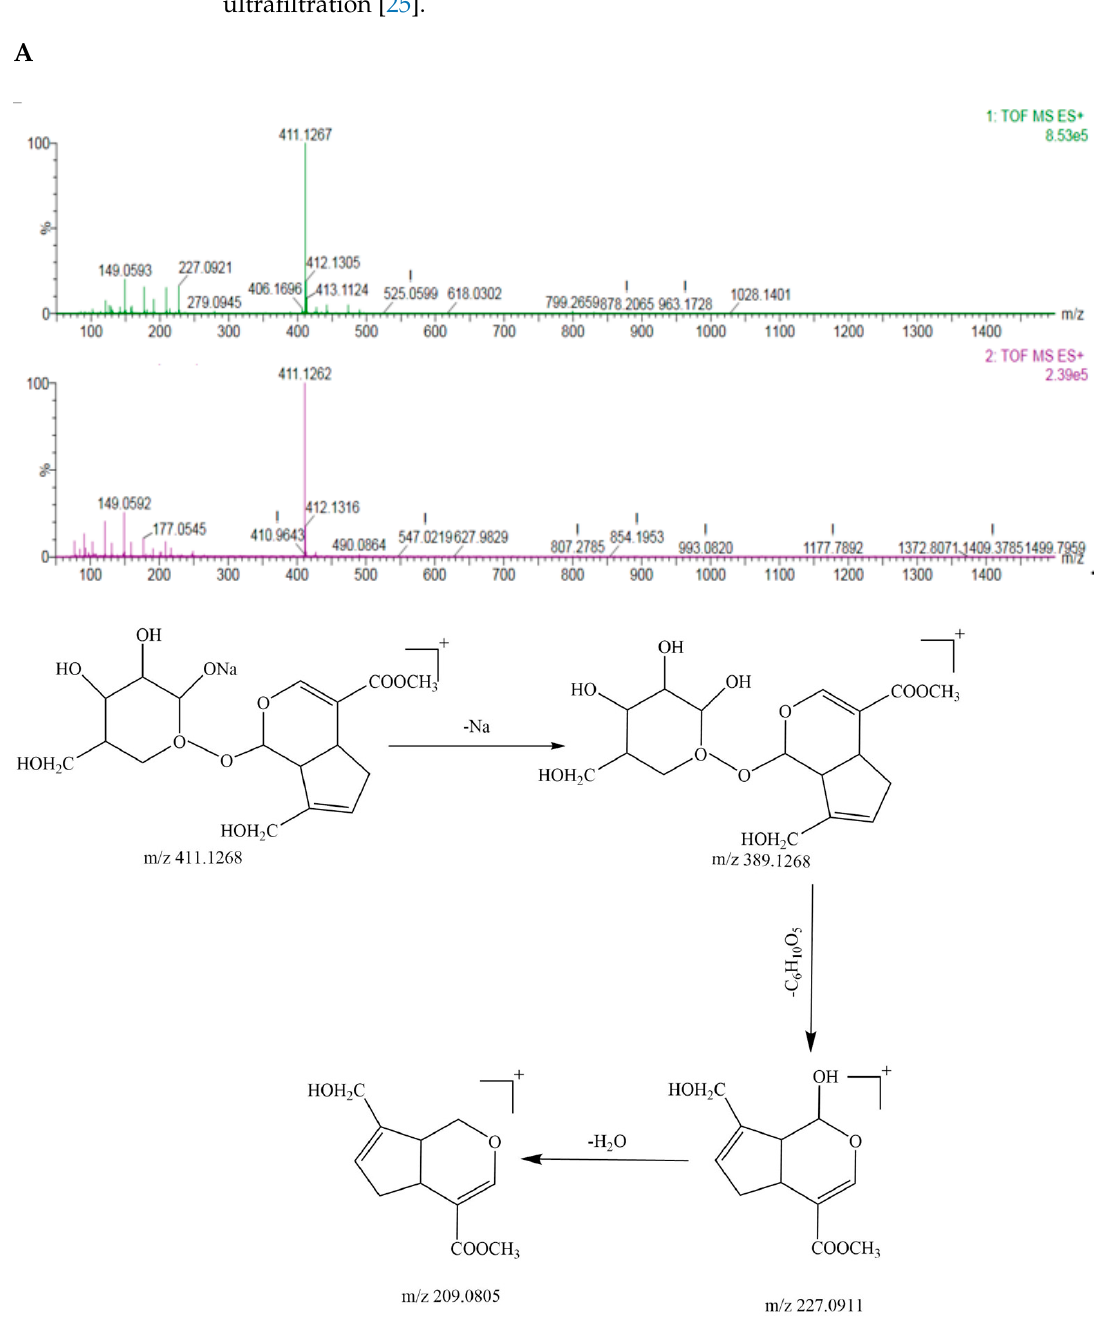
Figure 3. ( A ) The geniposide and crocin I standards, ( B ) the crude EGJ, and ( C ) the No.9 sample.